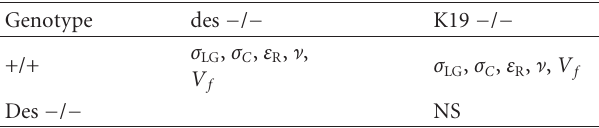
Table 3: Summary of parameters that display significant post hoc di ff erences ( P < 0 . 05) between genotypes for fibers harvested from young mice. Raw data, means, and standard errors are provided in Figure 2. NS: no significant di ff erence.